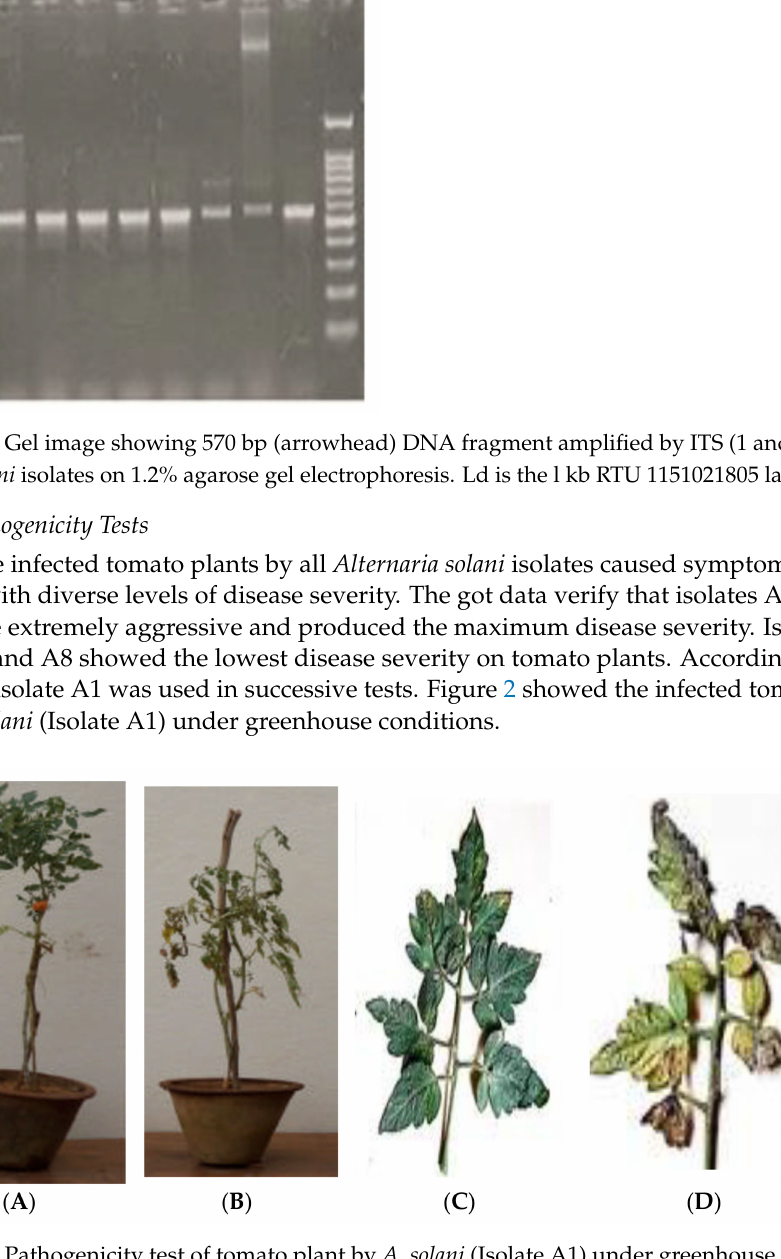
Figure 2. Pathogenicity test of tomato plant by A. solani (Isolate A1) under greenhouse conditions. ( A ). Healthy control in a pot. ( B ) Infected in a pot. ( C ). Healthy control as a single branch of tomato plant. ( D ). Infected branch of tomato